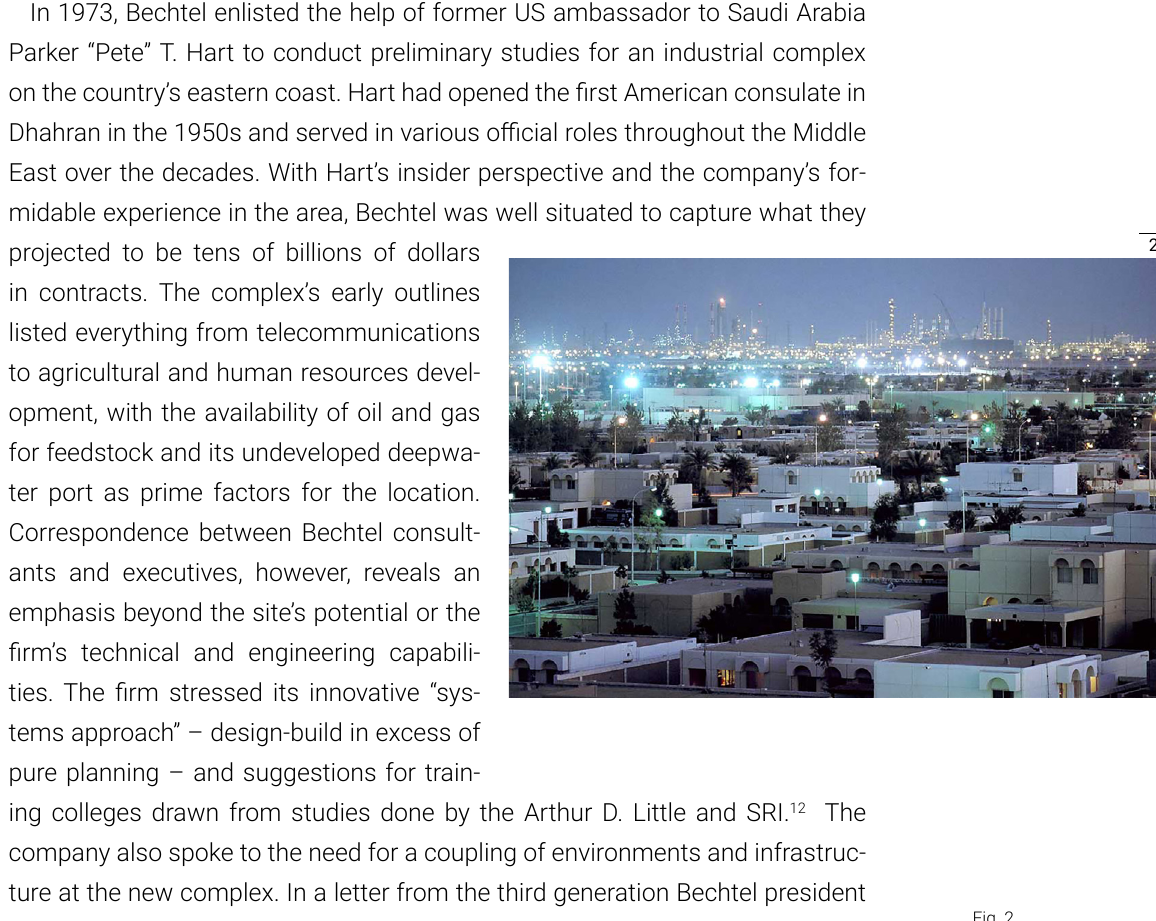
Fig. 2 Aerial view of Jubail residential sectors, beyond which lies a tangle of petrochemical infra-structure. Source: https://www.bechtel. com/projects/jubail-industri-